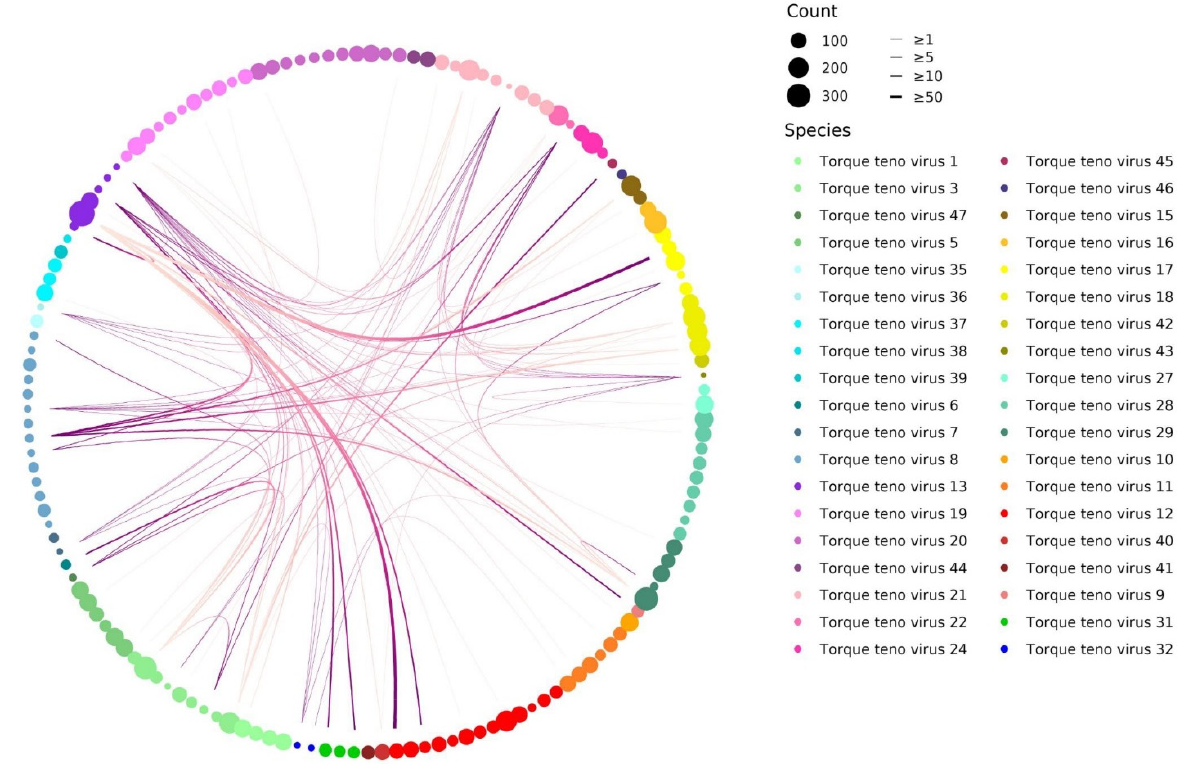
Figure 5. Relationship between co-detected TTV genotypes within a same patient. Each of the 149 TTV genotypes reported by mNGS in this paediatric cohort is represented by a dot of variable size depending on the number of times (i.e., counts) it is detected. Genotypes are grouped by species, and each of the 38 TTV species reported in this study being represented by a specific colour code. Each line indicates which TTV genotype (dark purple end) is frequently co-detected with which other (light purple end). A co-detection cut-off of ≥ 75% is used in order to illustrate only strong TTV genotypes co-detection rates.